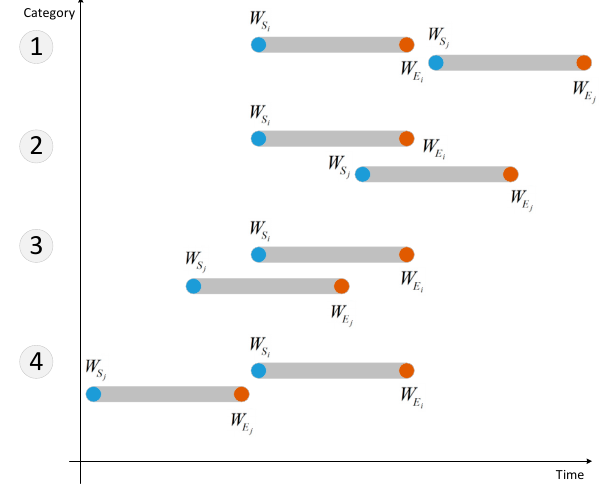
Figure 1. Time window relationship